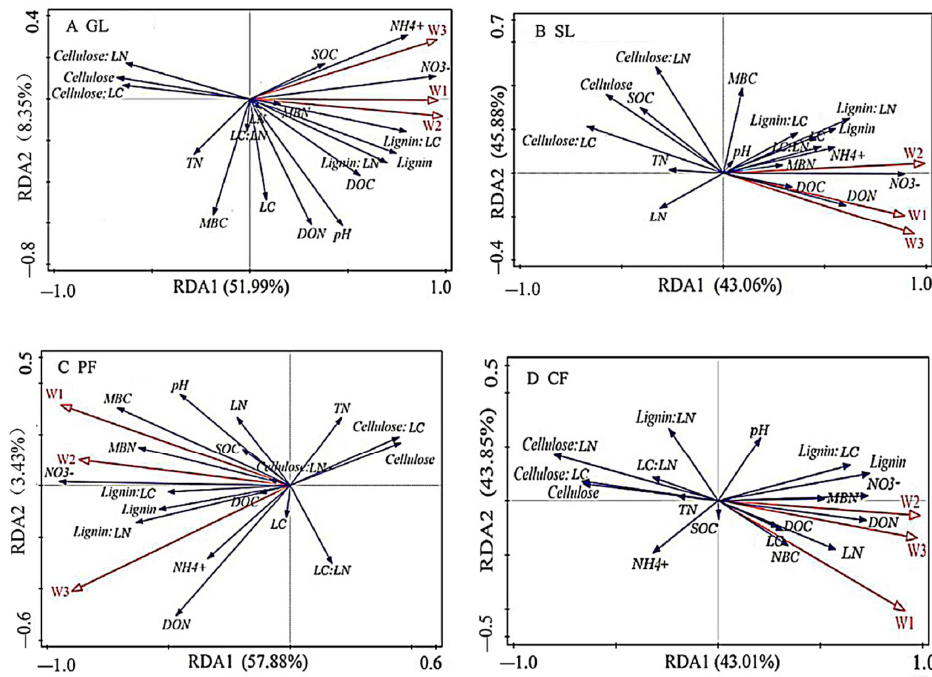
Figure 3. Redundancy analysis of vegetation litter decomposition rate and related factors of vegeta- tion and soil under different soil water. ( A – D ) represent the relationship between litter decomposition rate and plant, soil physicochemical properties under lower water (W1), medium water (W2) and higher water (W3) treatments of the four types vegetation (GL, SL, PF and CF), respectively. SOC: soil organic carbon, TN: total nitrogen, MBN: microbial biomass nitrogen, MBC: microbial biomass